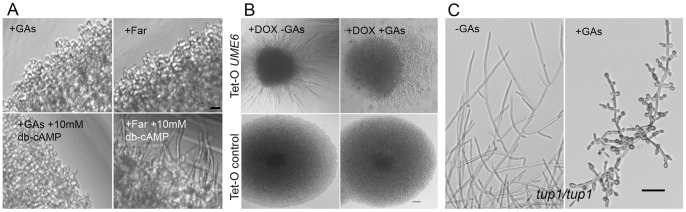
Effect of GAs on various hyphal growth regulatory pathways.(A) cAMP cannot rescue GAs mediated hyphal growth inhibition. C. albicans yeast cells were incubated in buffered RPMI medium +50 mM glucose at 37°C in 96 well plates without shaking. GAs or farnesol (Far) was added to the yeast cell suspension separately at a final concentration of 40 µg/ml or 200 µM, respectively. In addition to these hyphal growth inhibitors, db-cAMP was premixed at 10 mM (final concentration) prior to initiating the growth. After 24 h incubation, mictrotiter plates containing the samples were viewed directly through inverted microscope (Leica) with 10x ocular×20x objective lenses. Images were captured using a digital camera. To show the hypha or yeast growth distinctly, the peripheries of the growing area are presented. Scale bar = 10 µm. (B) GAs inhibit Ume6-induced filamentation. C. albicans expressing a Tet-inducible UME6 was incubated in a yeast promoting growth medium (YPD at 30°C) in the presence of doxycycline (DOX) and with or without GAs. As a control, strain CEC1049 (Table 1) lacking the PTET-UME6 construct was used. Individual colonies grown on YPD agar in microwells were visualized and images were recorded with a digital camera. Scale bar = 25 µm. (C) GAs inhibit the constitutive hyphal growth of tup1Δ/Δ mutant and induces bud formation. tup1Δ/Δ cells were grown in yeast growth supporting medium (liquid YPD at 30°C) in the presence or absence of GAs for 16 h. Scale bar = 25 µm. A tup1Δ/Δ-URA3 marker complemented strain was also included in parallel assays and similar results were found (pictures not shown).